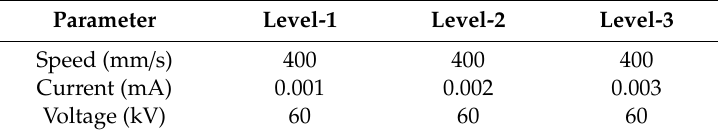
Table 6. The levels of current changes.